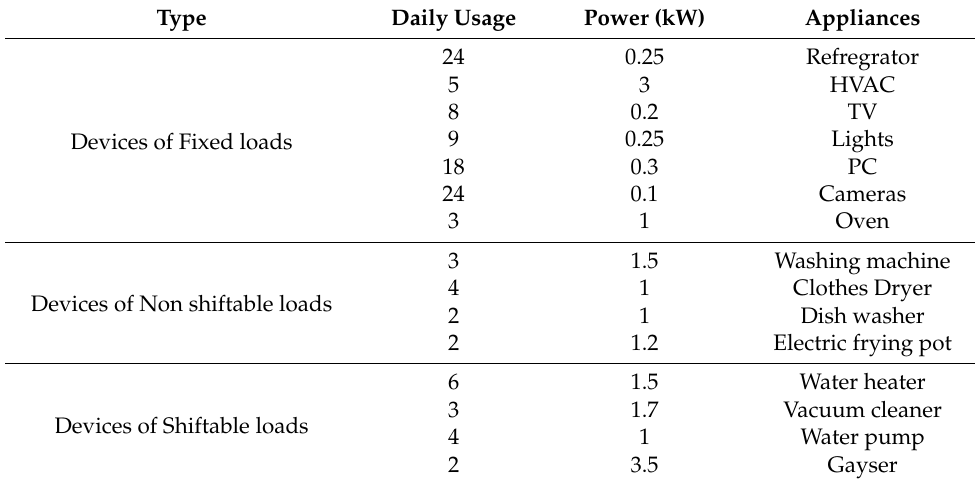
Table 3. Micro grid appliances detail